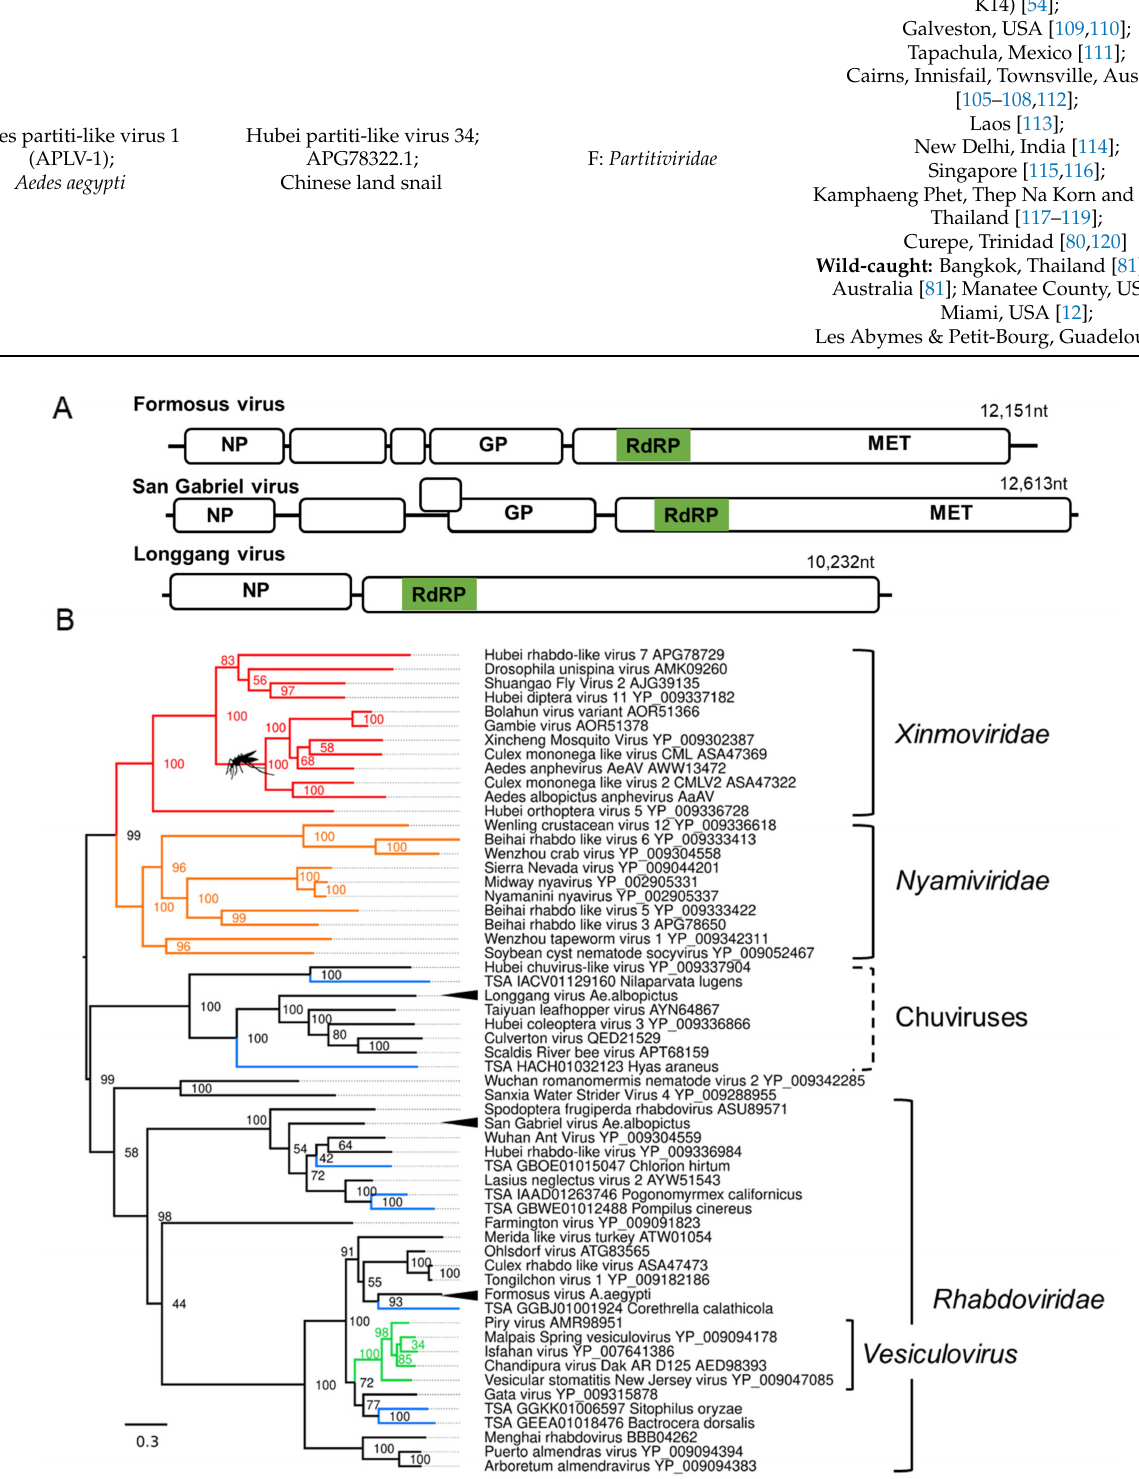
Figure 2. Novel negative-sense RNA viruses of Ae. aegypti and Ae. albopictus mosquitoes. ( A ) Genome structure and organisation of novel mononegaviruses. NP, nucleocapsid; GP, Glycoprotein; MET, methyltransferase. ( B )